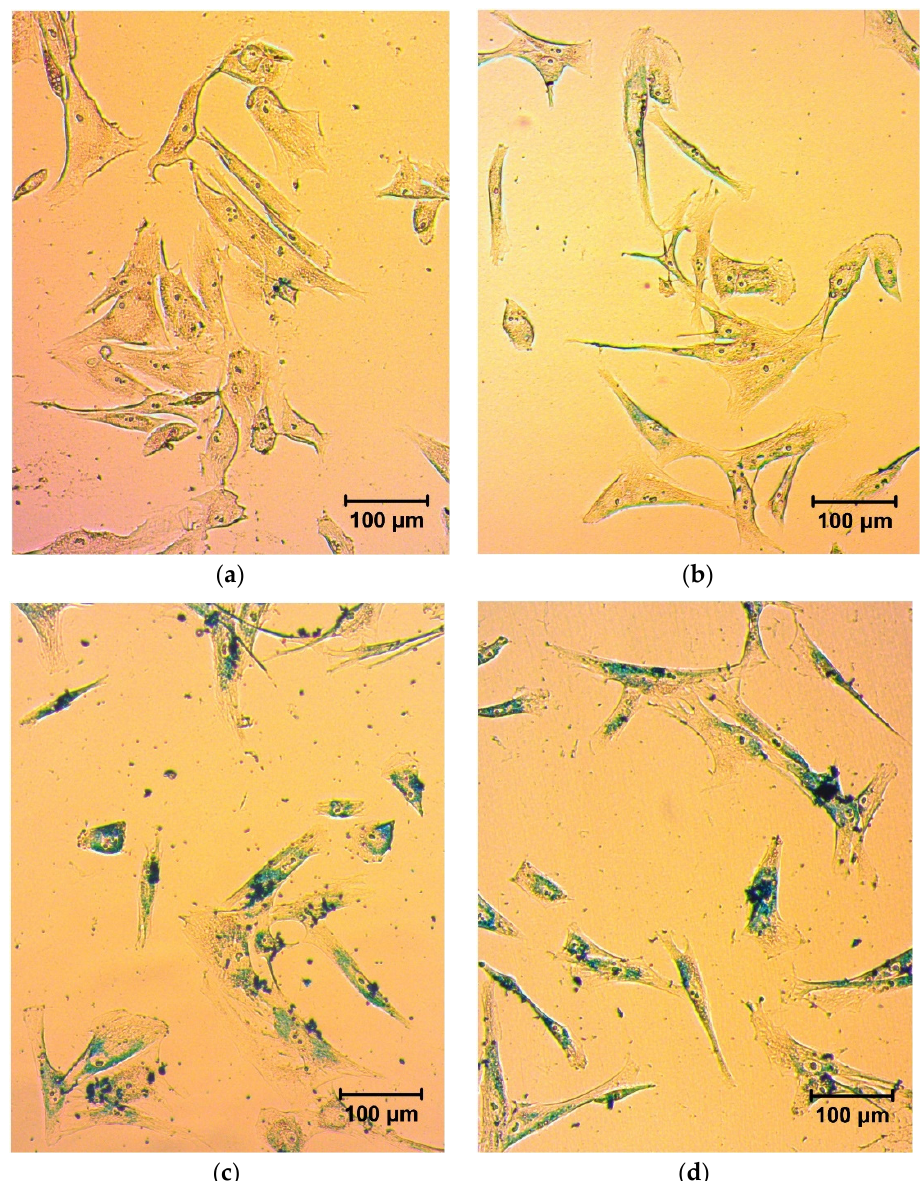
Figure 4. Prussian blue staining of skin fibroblasts after incubation with MNPs. Cells were incubated for 18 h with MNPs in various concentrations, washed from unbound nanoparticles, detached, seeded on culture-treated plastic, incubated for 18 h, fixed, and stained. ( a ) control without MNPs; ( b ) 2 µg/cm 2 ; ( c ) 32 µg/cm 2 ; ( d ) 512 µg/cm 2 . Magnification × 100.